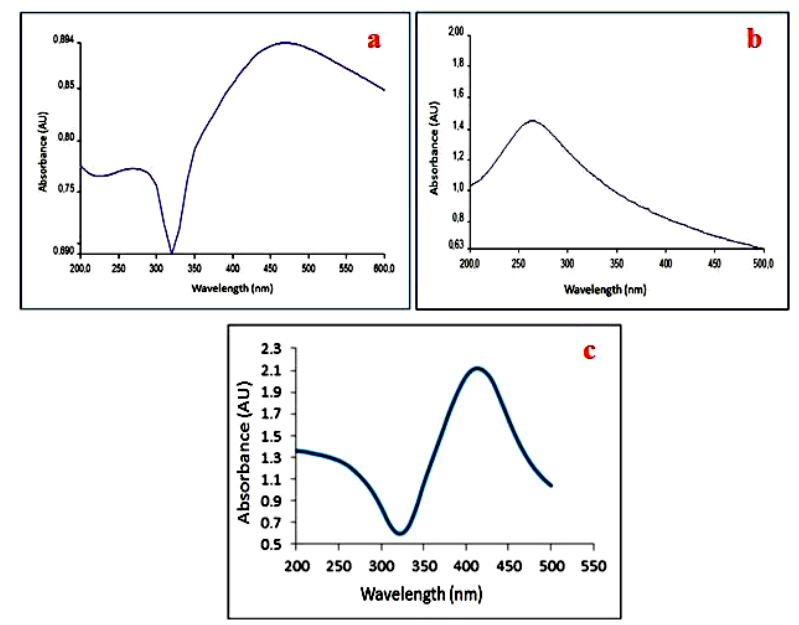
Figure 6. UV-vis spectra obtained after the green synthesis of Ag-NPs ( a ), rGO ( b ), and GAg ( c ).